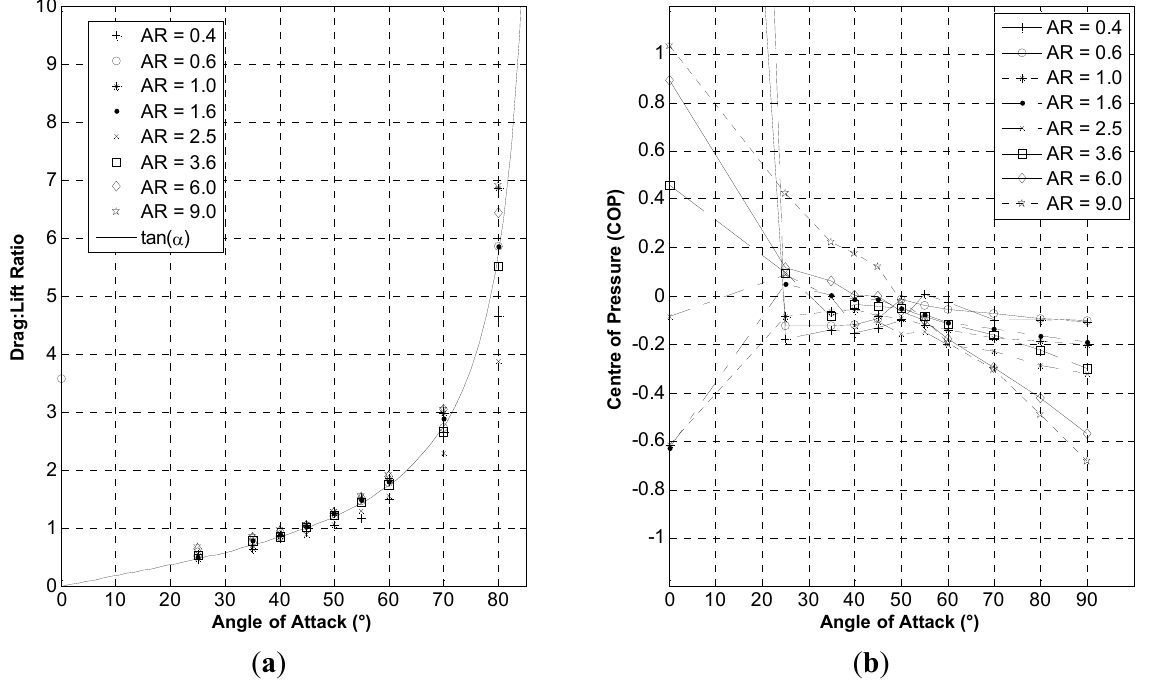
Figure 9. ( a ) Free-stream drag: lift ratio and ( b ) CoP as a function of AR and α